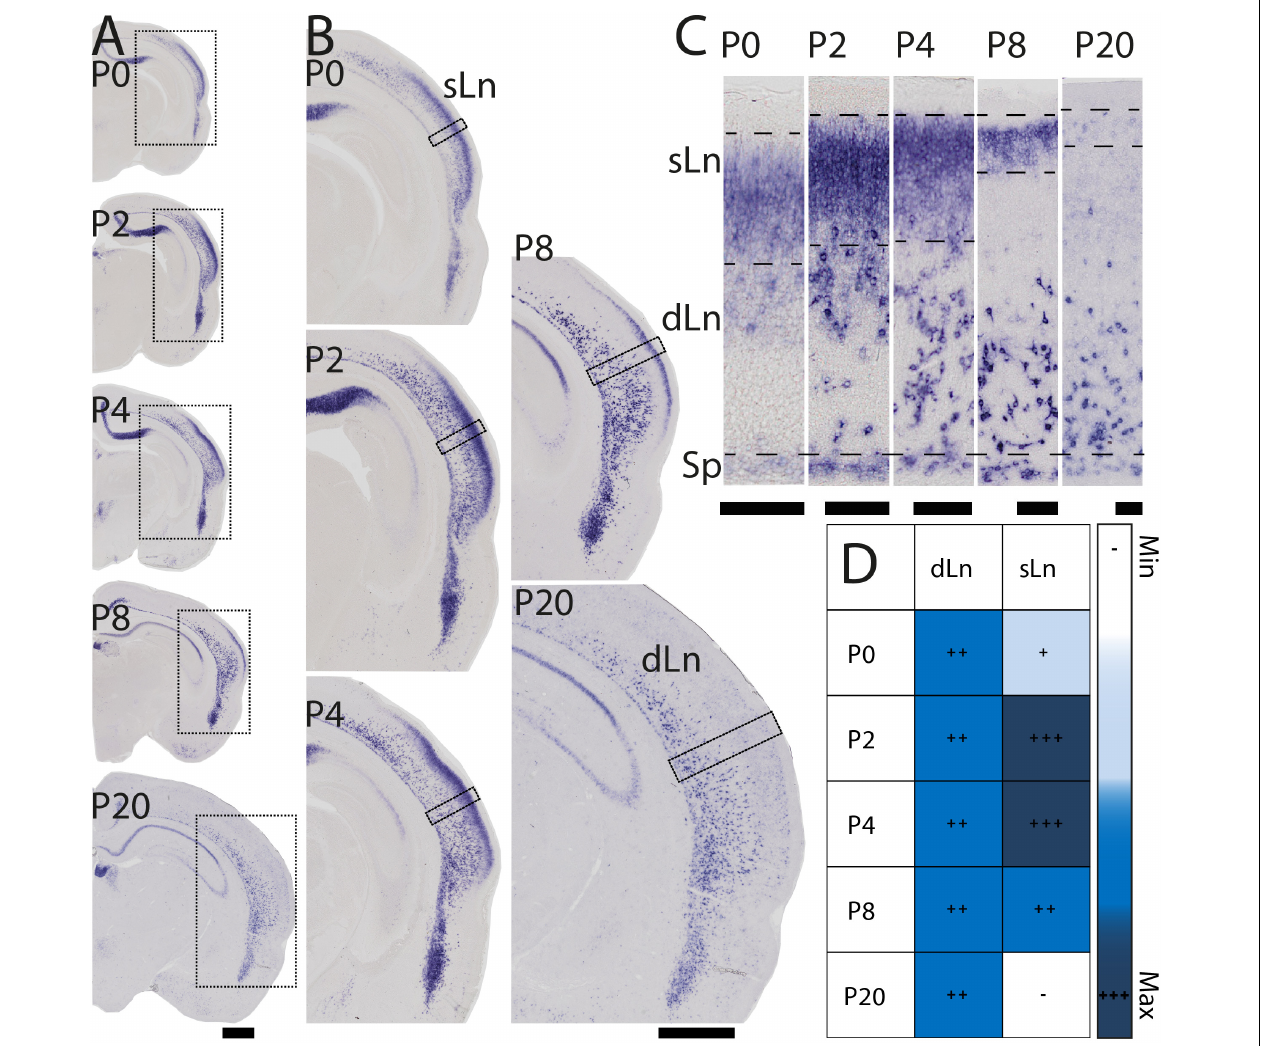
FIGURE 3 | Early postnatal development of Nurr1 expression in posterior cortical regions. (A) Nurr1 expression on P0, P2, P4, P8, and P20. (B) Higher magnification Nurr1 labeled regions from P0 to P20. (C) Higher magnification images of the columns indicated by black squares in panel (B) showing dLn and sLn from P0 to P20. (D) Table of early postnatal development of Nurr1 expression in sLn. White and “–” indicate no expression, light blue and “ + ” indicate little expression, higher expression is shown in darker color and more “ + ” signs. N = 2 rats for each date. Scale bar in panels (A,B) = 1 mm. Scale bar in panel (C) = 100 µ m.